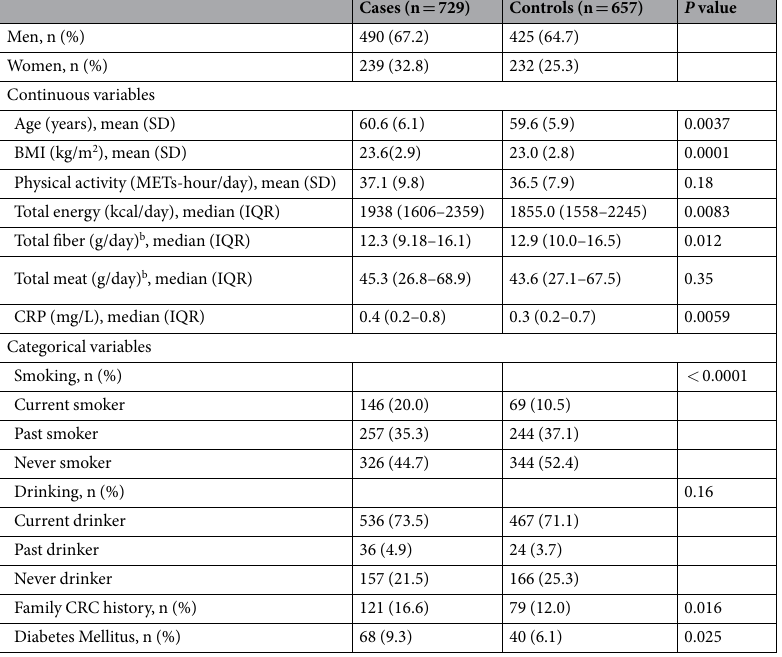
Table 1. Characteristics of all study subjects. a N, number of subjects; BMI, body mass index; METs, metabolic equivalents; CRC, colorectal cancer; SD, standard deviation; IQR, inter-quartile range. b